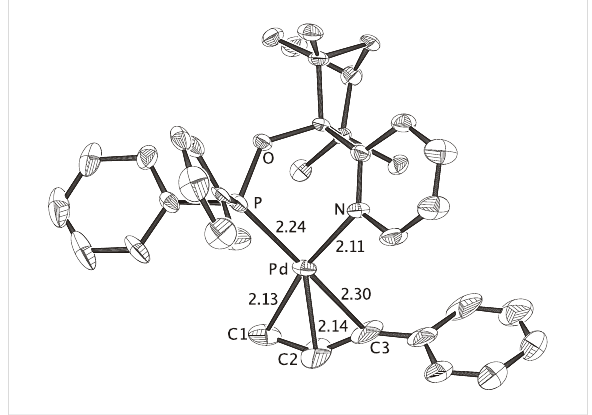
Figure 1: X-ray crystal structure of the cationic complex Pd-FENOP (CCDC 299944), the perchlorate counterion and hydrogen atoms are omitted. The allylic phenyl groups is positioned trans to phosphorus. In agreement with the the " trans rule", C3-Pd is longer then C1-Pd.